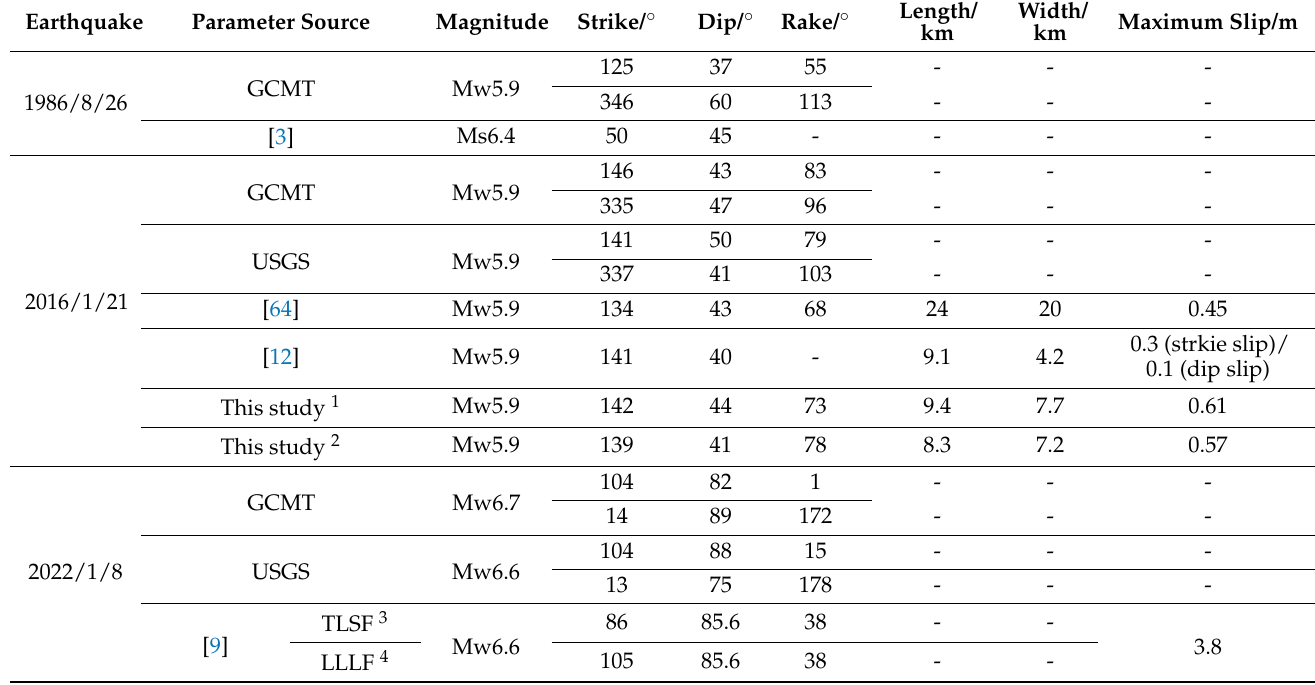
Table 2. Focal mechanism parameters of the 1986, 2016, and 2022 Menyuan earthquakes.